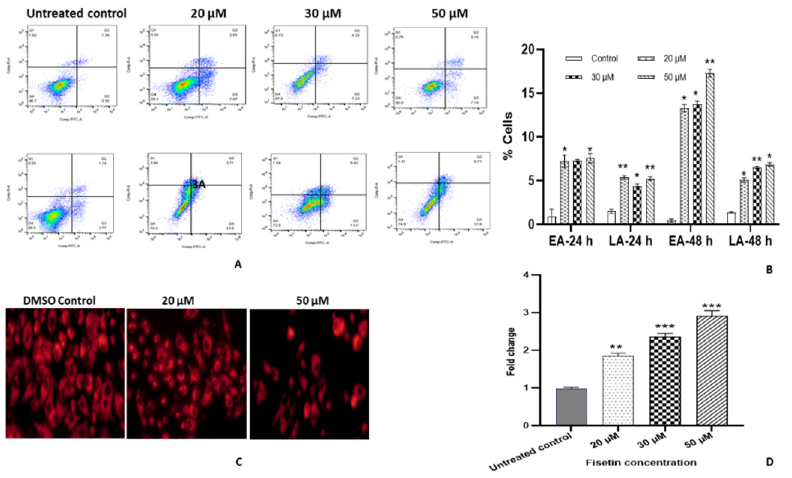
Figure 3. Fisetin induces apoptosis in HeLa cells ( A ) Fisetin-treated HeLa cells with 20 µM, 30 µM and 50 µM for 24 and 48 h in comparison with the DMSO control followed by double staining. Representative picture of dot plots showing different stages of apoptosis. Left lower quadrant (FITC − /PI − ) = viable cells, right lower quadrant (FITC + /PI − ) = early apoptotic cells, right upper quadrant (FITC + /PI + ) = late apoptotic cells. ( B ) Graph illustrating the percentage distribution of different stages of apoptotic cells in their respective quadrant by flow cytometry. Early and late apoptotic cell proportions was found to be increased both in time and concentration-dependent manner compared with the control. ( C ) TMRE staining of treated cells showing reduction in fluo- rescent intensity signifying reduction in mitochondrial membrane potential. Images were captured by fluorescent microscope. ( D ) Graph representing TMRE fluorescence of treated HeLa cells with fisetin 20, 30 and 50 µ M for 48 h, which exhibited reduction in mitochondrial membrane potential from 81% to 64% and 54%, respectively, in comparison with the untreated control. Data are presented as the mean ± standard deviation of three independent experiments. Two-way ANOVA * = p < 0.05; ** = p < 0.01, *** p <